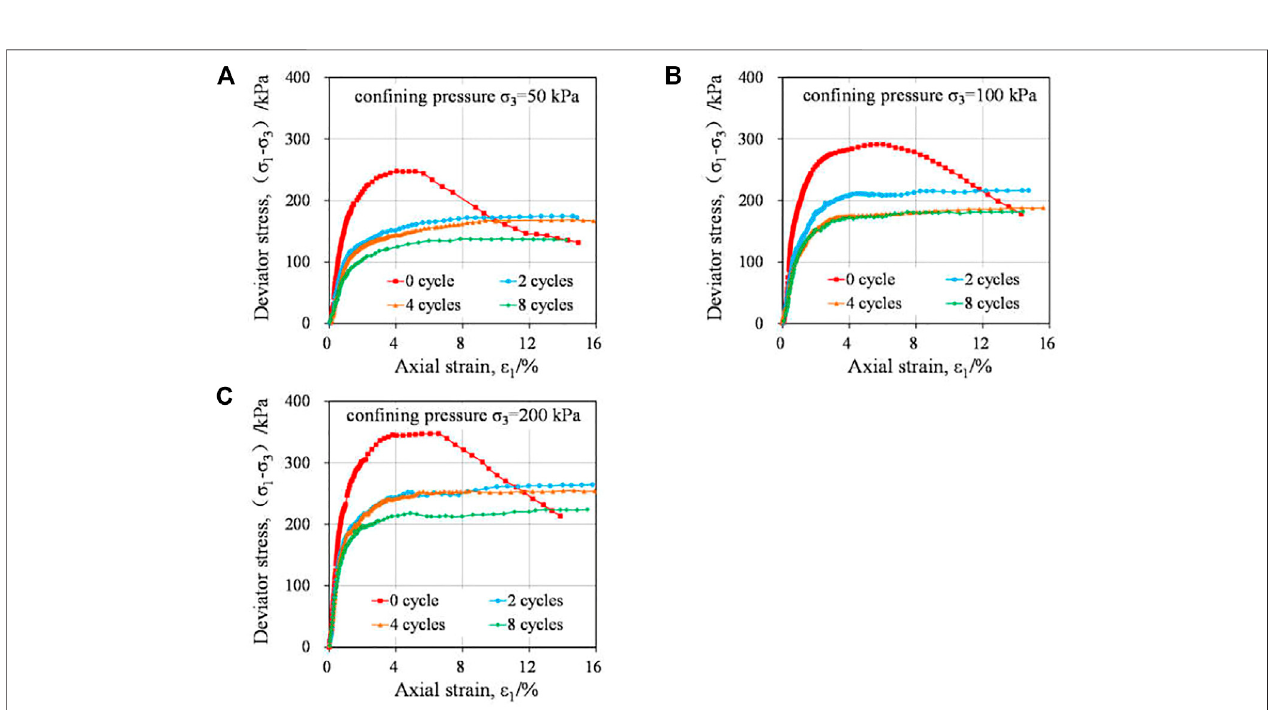
FIGURE 5 | Stress-strain curves in the triaxial shear test: (A) σ 3 = 50 kPa, (B) σ 3 = 100 kPa, and (C) σ 3 = 200 kPa.